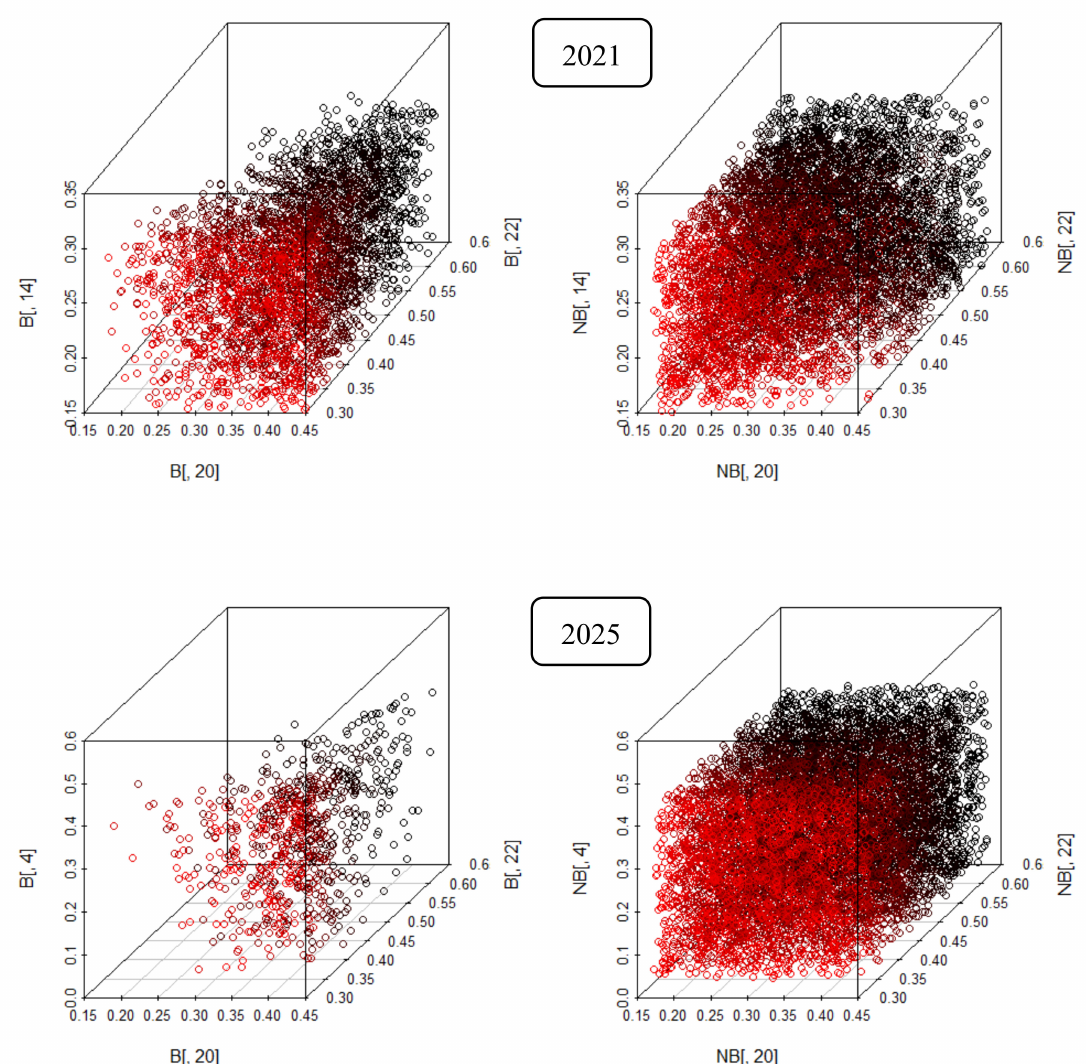
Figure 10. Regionalization of variables III1, the distribution of the material from batteries to traditional batteries (III3), and the distribution of material from lithium carbonate to lithium hydroxide (II9) from the simulations for 2021 and